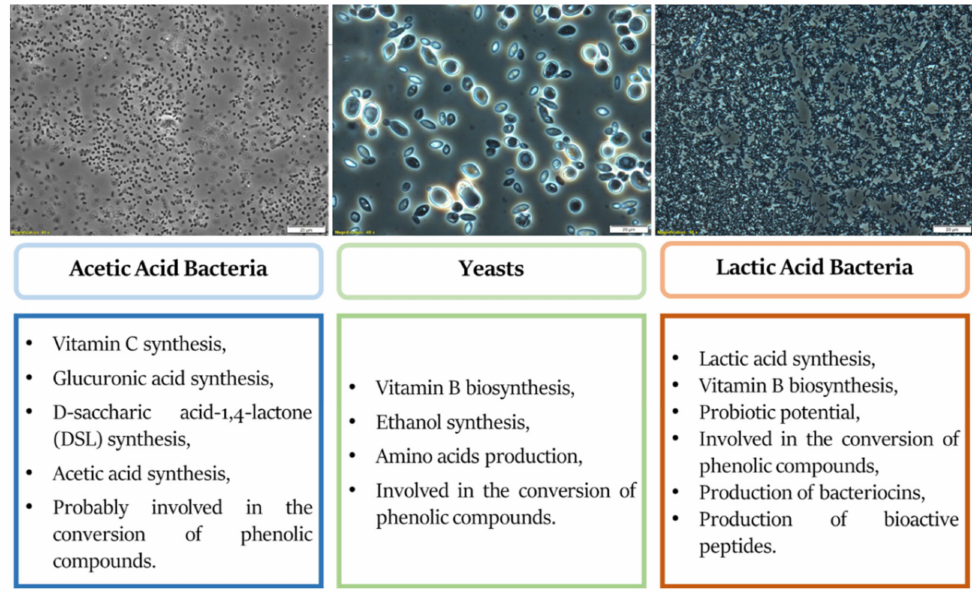
Figure 4. The influence of the SCOBY consortium on the health-promoting properties of fermented